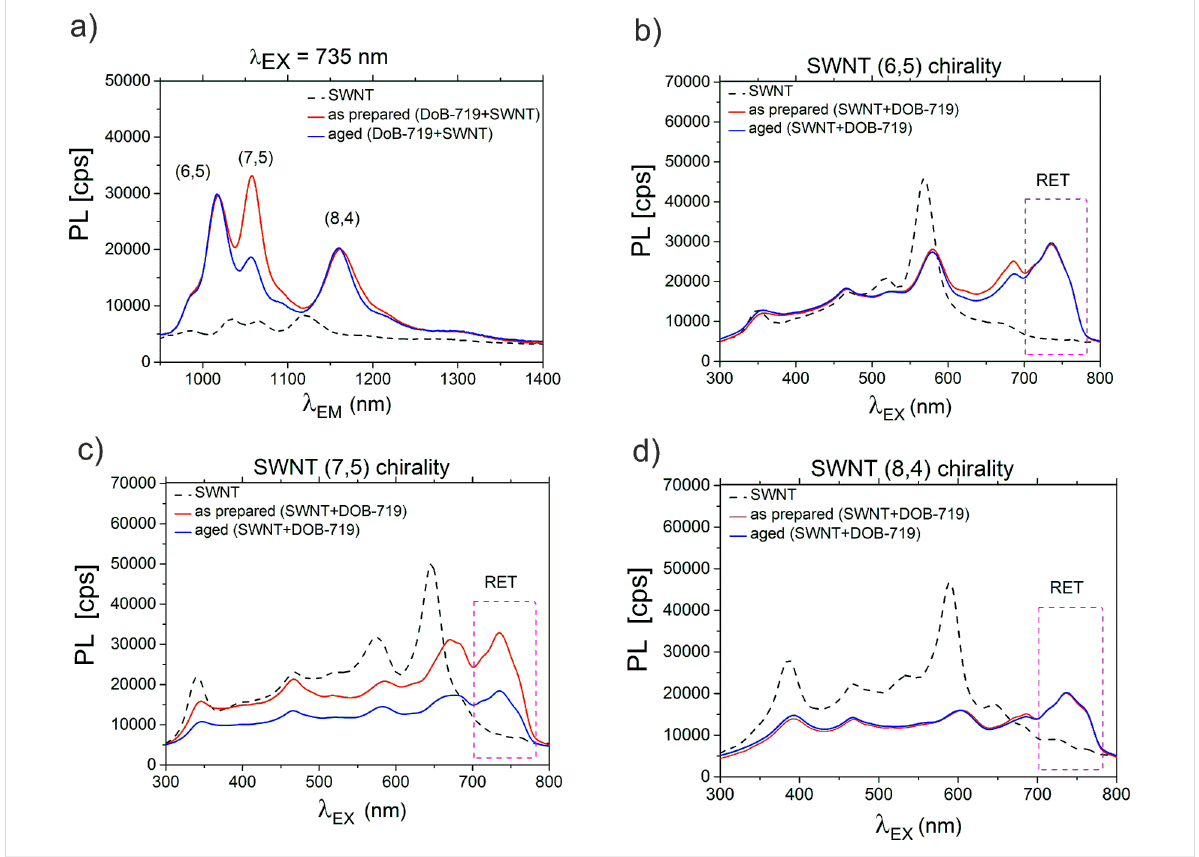
Figure 4: PL spectra for the as-prepared (red curves) and aged (blue curves) mixtures of DOB-719 and SWNTs and dispersions of neat SWNTs (dashed curves) in water. (a) PL emission spectra at λ EX = 735 nm and PL excitation spectra (b) (6,5), (c) (7,5), and (d) (8,4) chiralities. PL spectra for the as-prepared and aged mixtures are extracted at λ EM = 1016, 1059, and 1161 nm for the (6,5), (7,5), and (8,4) chiralities, respectively. PL spectra for neat SWNTs are extracted at λ EM = 985, 1032, and 1121 nm for the (6,5), (7,5), and (8,4), respectively. The RET from the dye to the SWNT at λ EX = 735 nm is indicated in panels